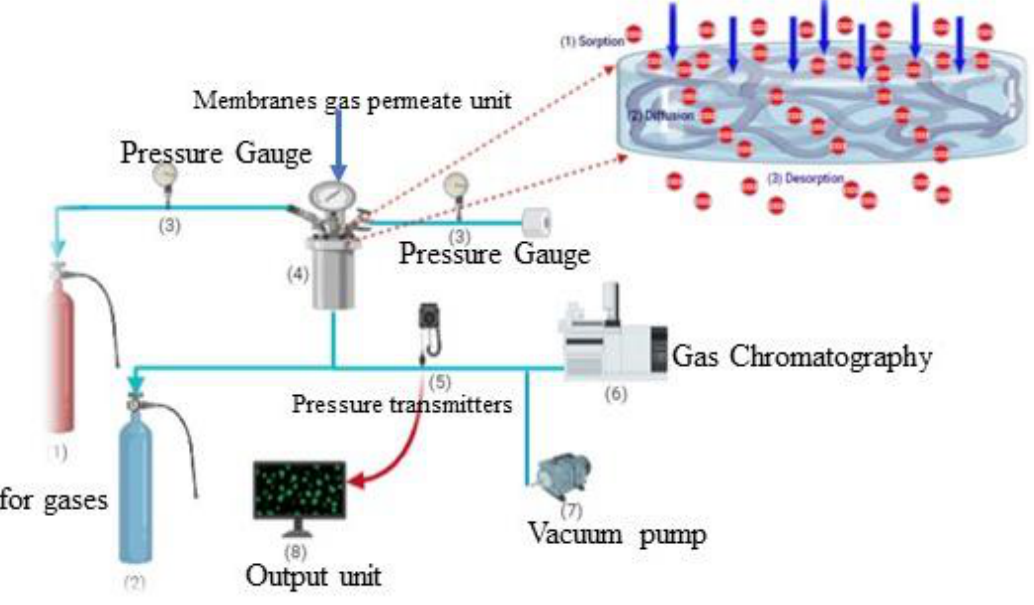
Figure 1. The setup for gas permeation is depicted in this